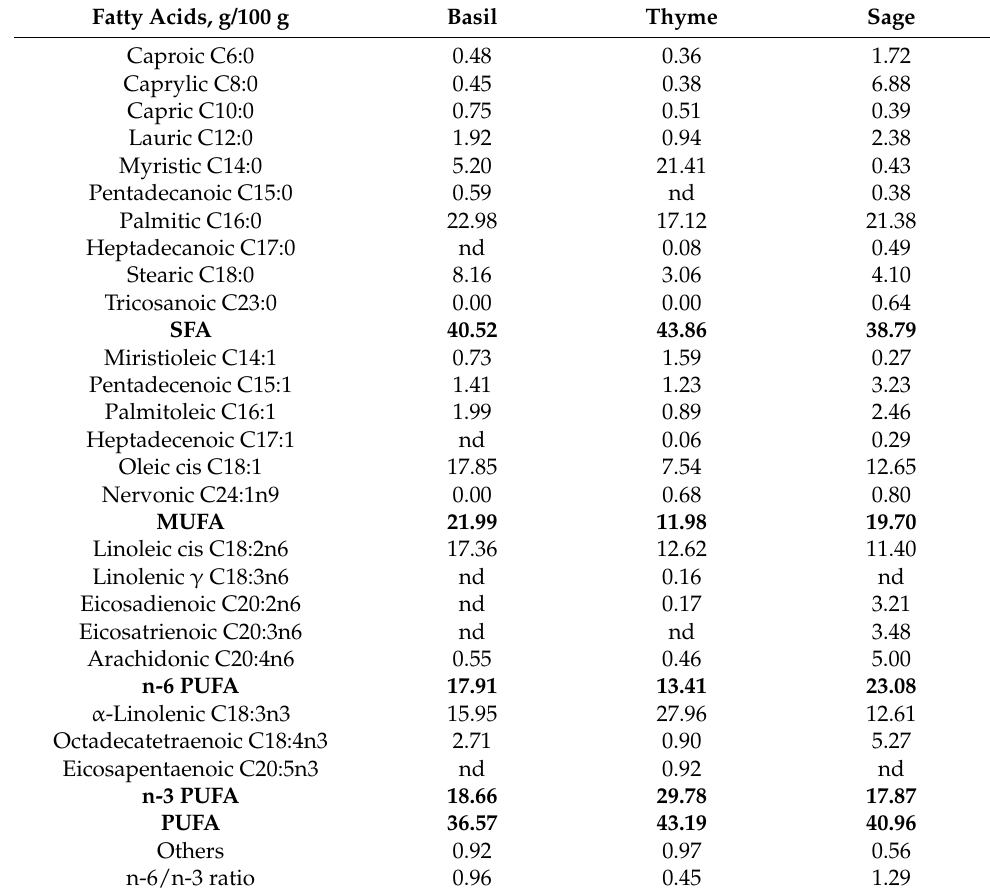
Table 2. Fatty acid composition of the plants. Fatty Acids, g/100